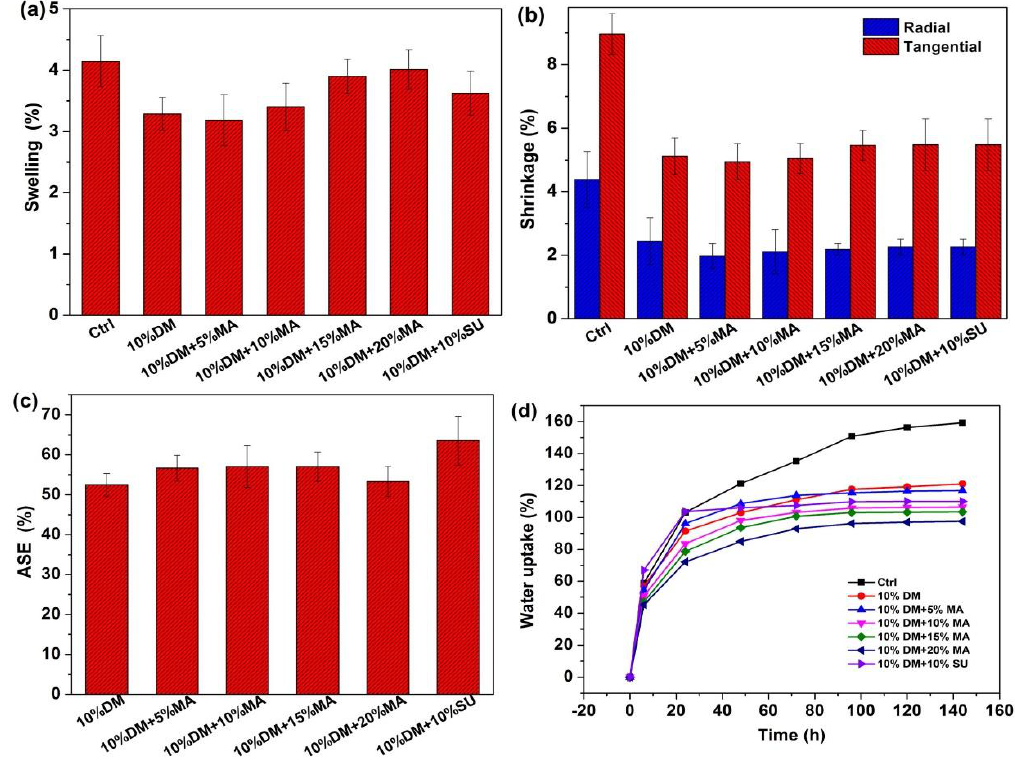
Figure 4. ( a ) Swelling, ( b ) shrinkage, and ( c ) ASE of wood before and after treatment with 10% DM, and MA at different concentrations and 10% DM and 10% SU. Water uptake of untreated wood